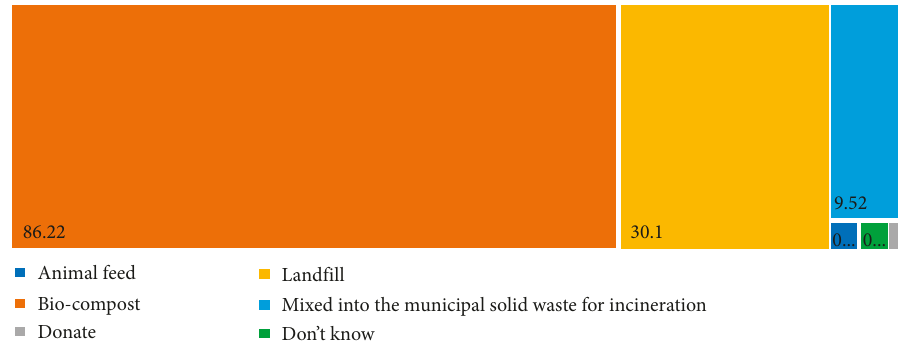
Figure 12: The effective ways for reducing food waste that Malaysians